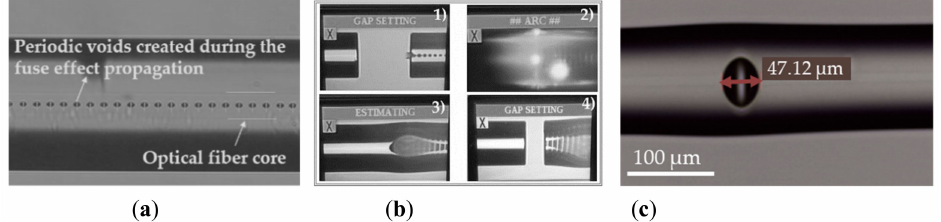
Figure 1. ( a ) Microscopy of an optical fiber containing the voids generated by the fuse e ff ect; ( b ) Procedure used to fabricate the Fabry-Perot interferometric (FPI) micro-cavity by recycling the damaged optical fiber; ( c ) Microscopy image of the produced in-line FPI micro-cavity used for the experimental